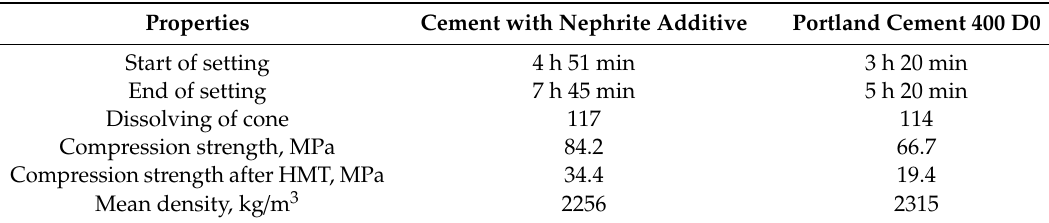
Table 5. Physical and mechanical properties of cements.